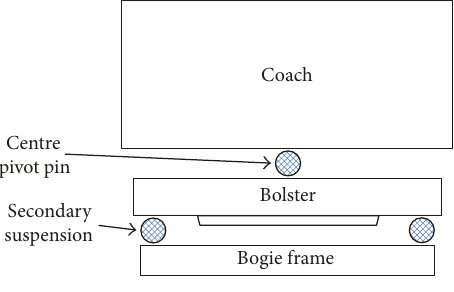
Figure 5: Scheme of the secondary suspension. Table 4: Stiffness components of the air